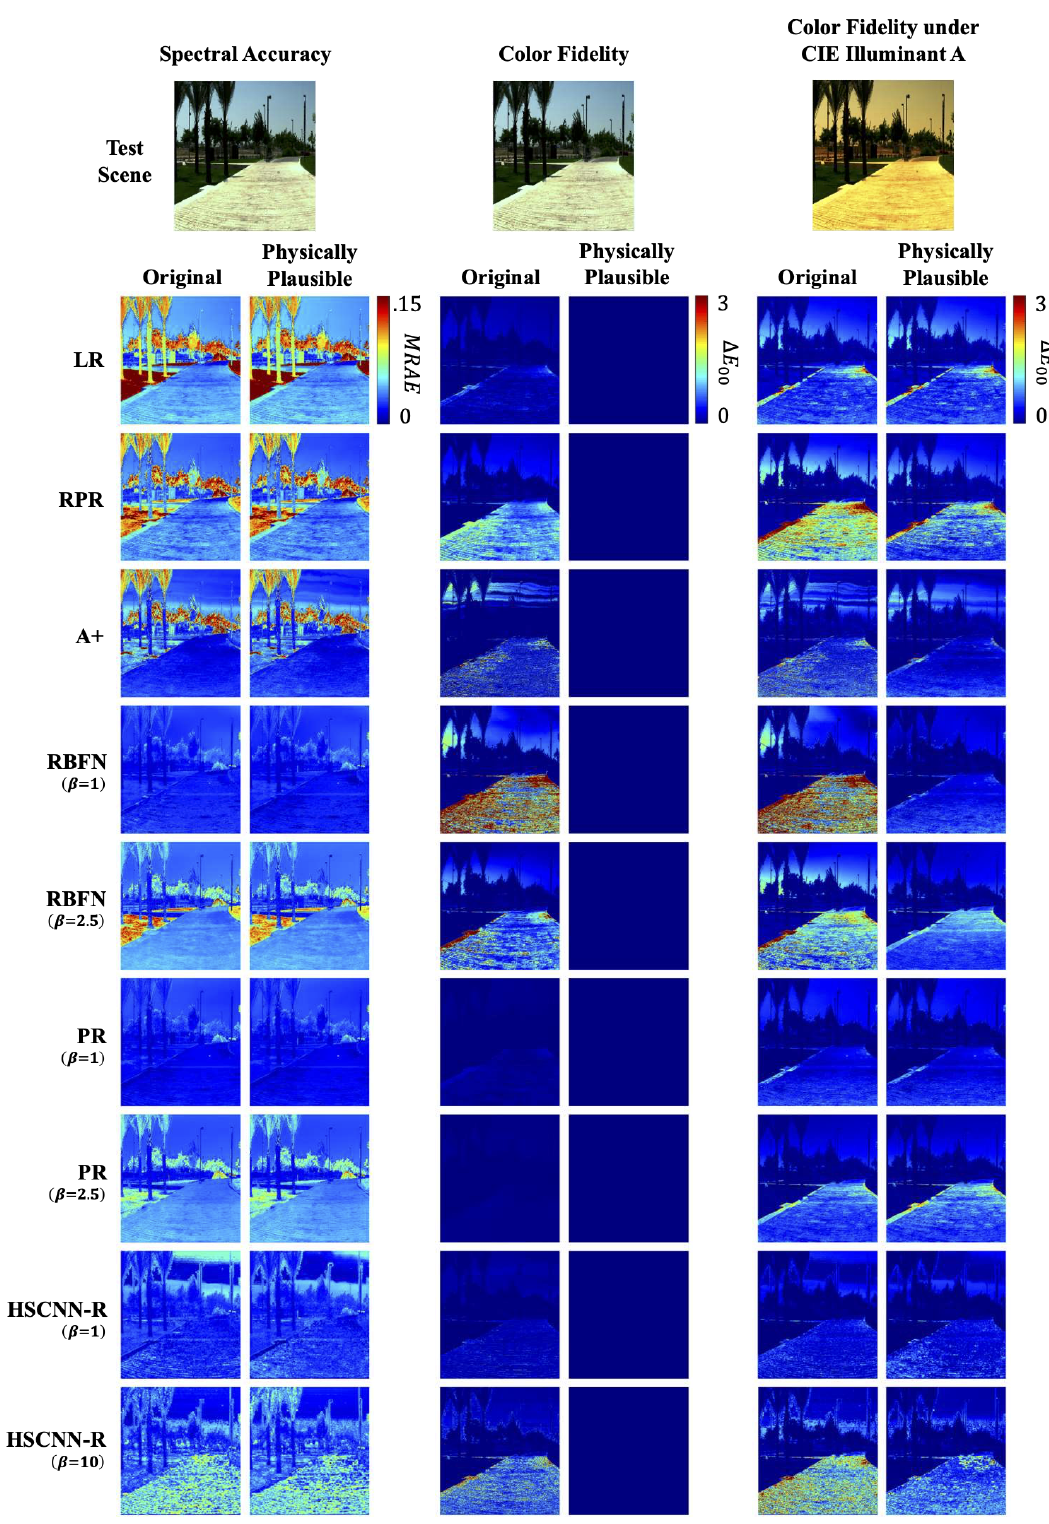
Figure 13. The reconstruction error maps of an example scene in terms of spectral accuracy ( left ; in MRAE), color fidelity ( middle ; in ∆ E 00 ) and color fidelity under CIE Illuminant A ( right ; in ∆ E 00